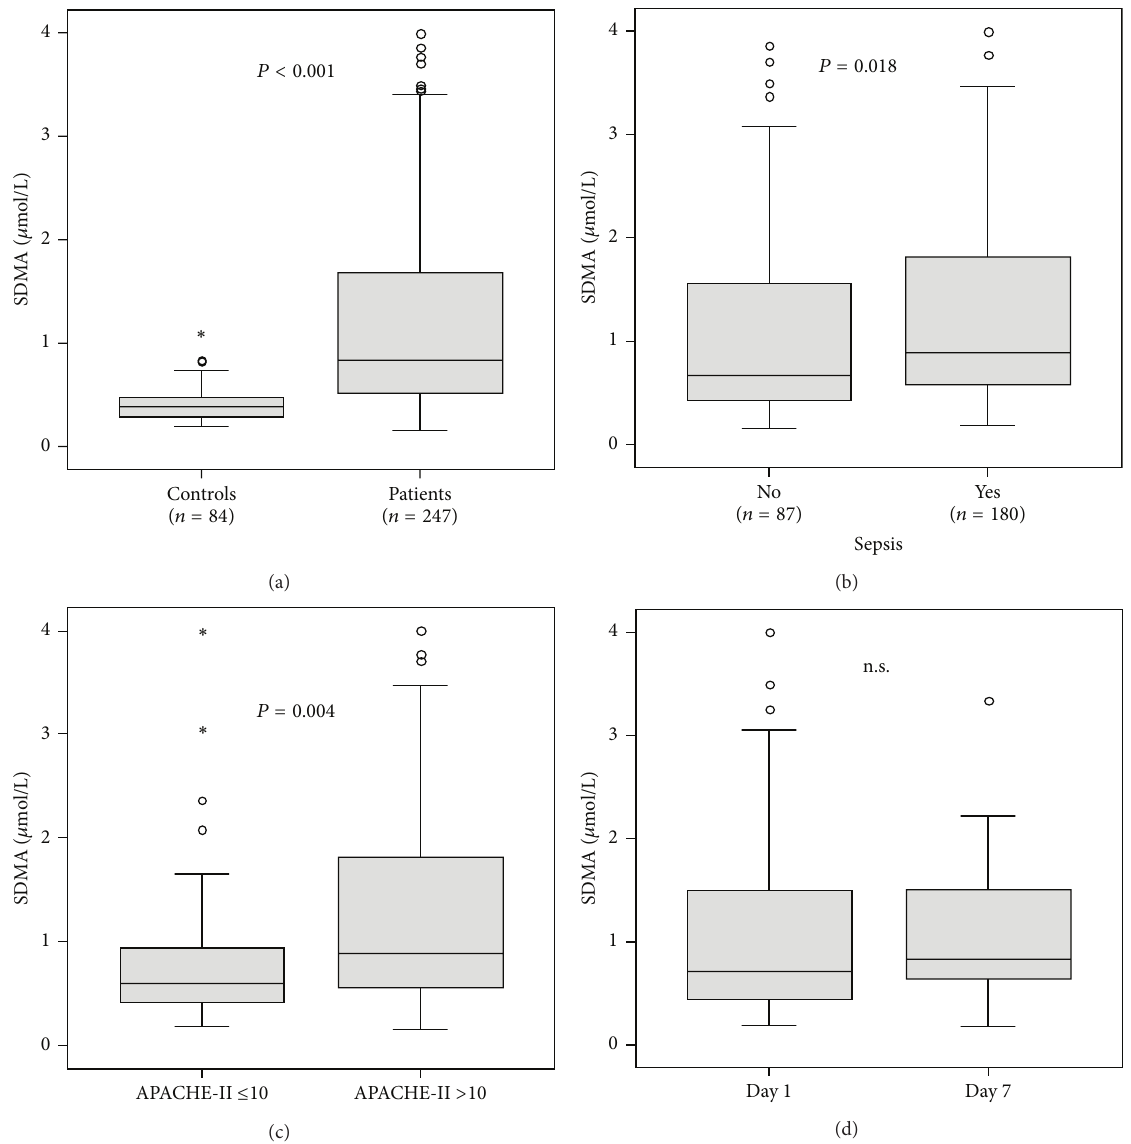
Figure 1: Serum SDMA concentrations in critically ill patients. (a) At admission to the medical ICU, serum SDMA levels were significantly ( 𝑃 < 0.001 , 𝑈 test) elevated in critically ill patients ( 𝑛 = 247 ) as compared to healthy controls ( 𝑛 = 84 ). (b) SDMA serum levels at ICU admission were significantly increased in ICU patients with sepsis ( 𝑛 = 180 ) compared to patients without sepsis ( 𝑛 = 87 ). (c) SDMA serum levels at ICU admission were significantly increased in ICU patients with higher degree of disease severity, as displayed by the APACHE-II score. (d) In 42 patients, SDMA levels were measured at admission (day 1) and at 1 week (day 7) of ICU therapy. SDMA levels remained stable during the first week of ICU treatment (paired Wilcoxon